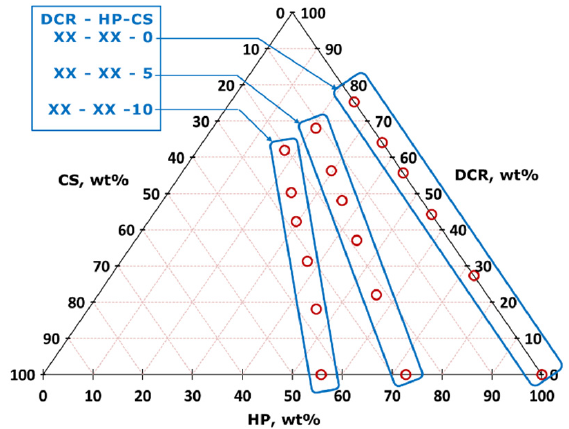
Figure 1. Ternary diagram of the dried composed material composition by wt.%. Three groups of